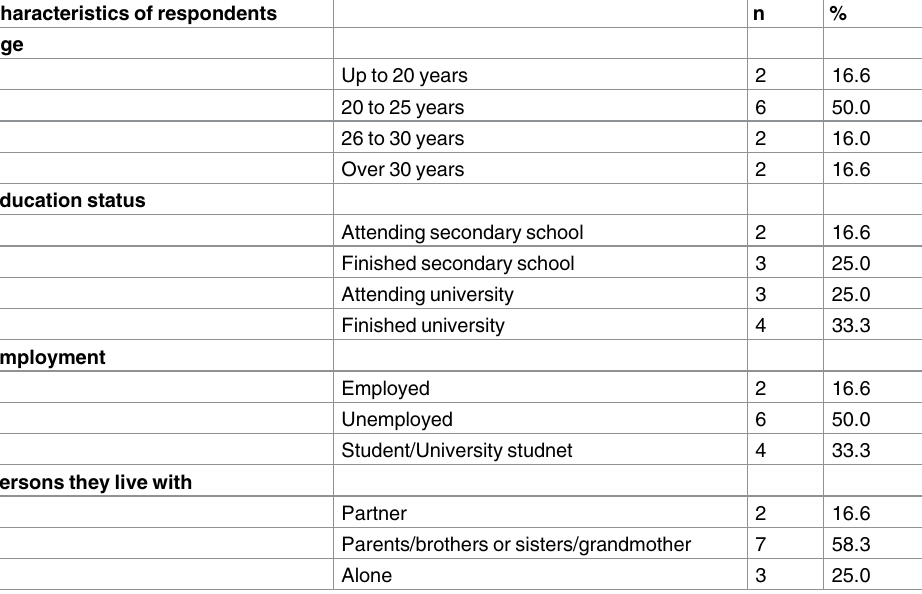
Table 1. Basic socio-demographic characteristics of the